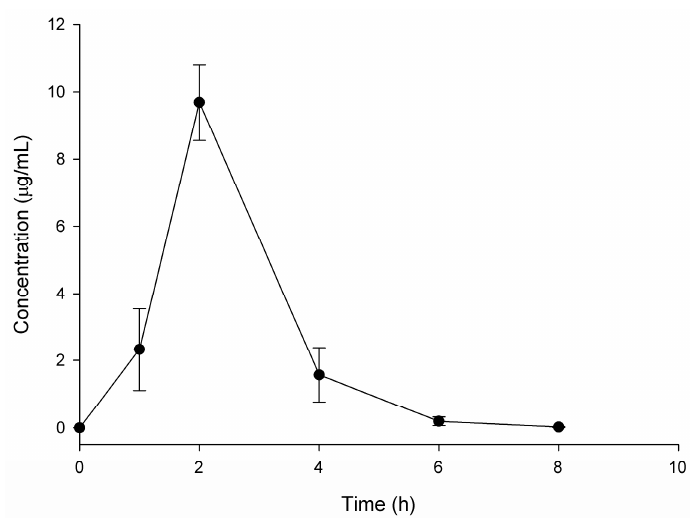
Table 4. Pharmacokinetic parameters of glucosamine (450 mg) administered in one Phycox ® soft chew in the dog ( n = 4).